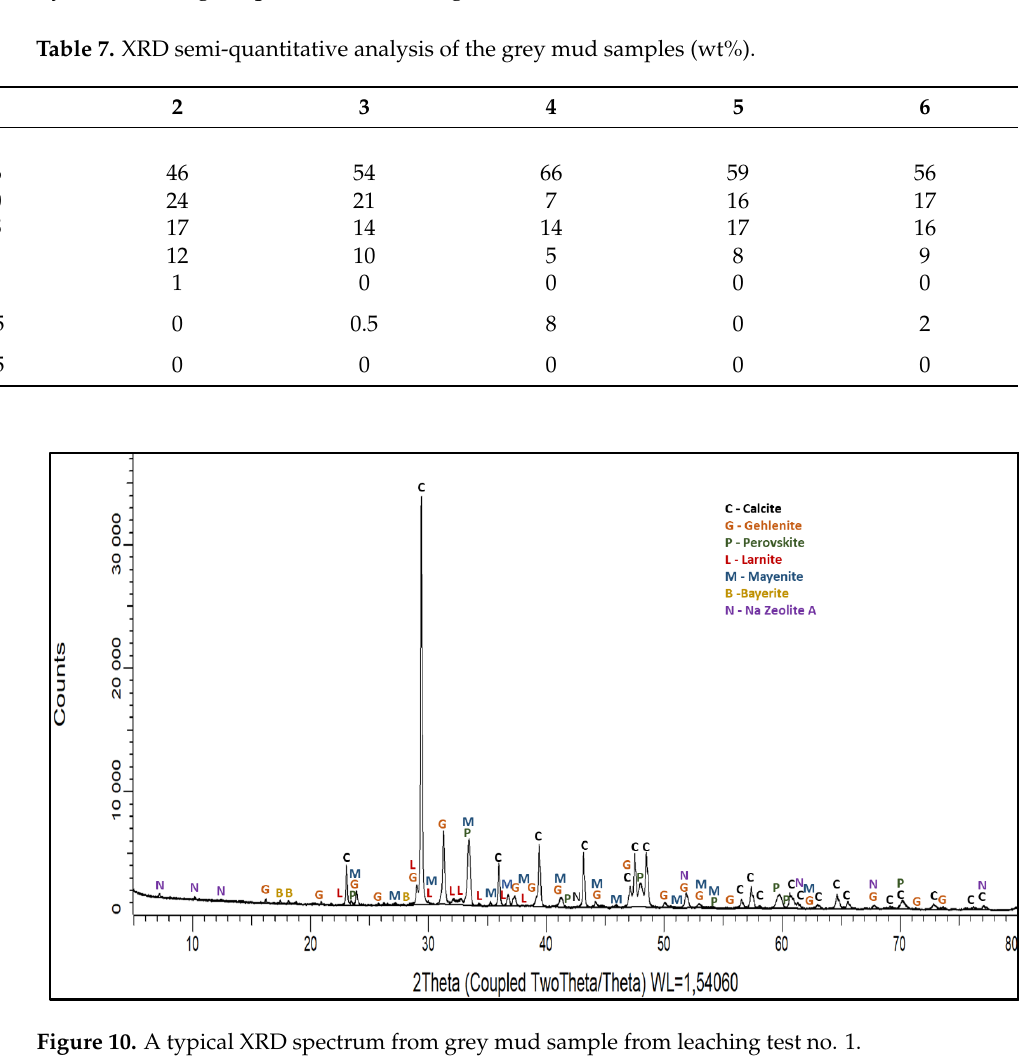
Figure 10 . A typical XRD spectrum from grey mud sample from leaching test no. 1. Figure 10. A typical XRD spectrum from grey mud sample from leaching test no.